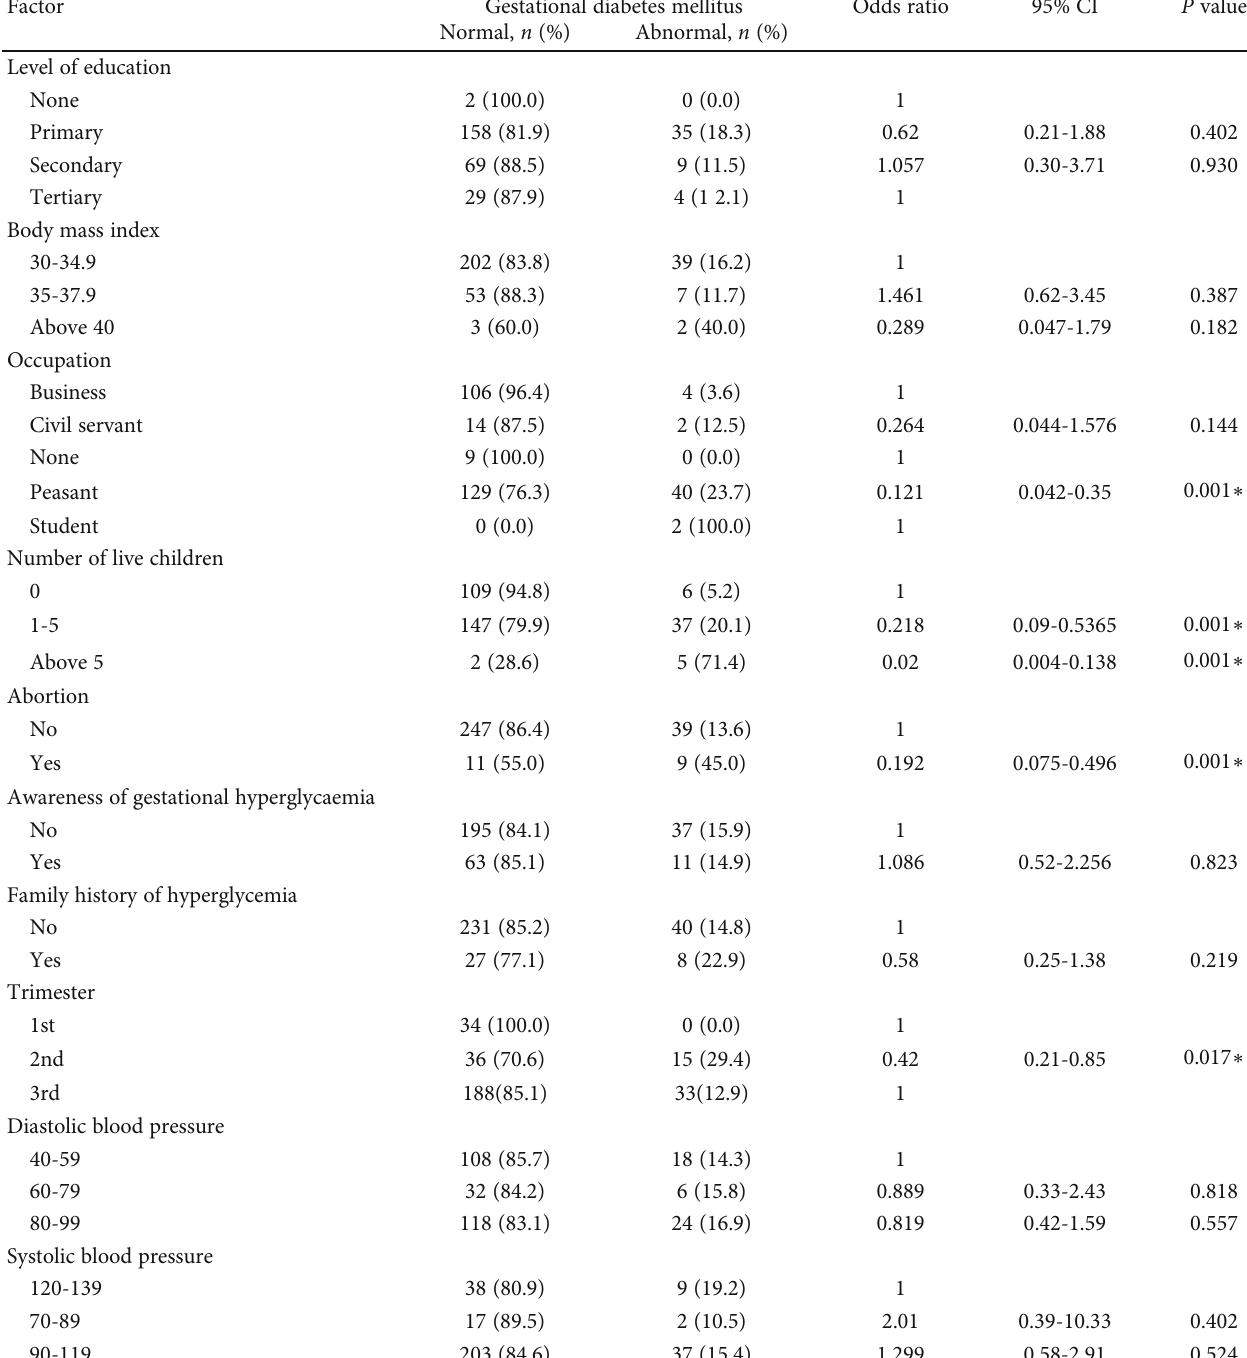
Table 3: Maternal risk factors associated with gestational hyperglycaemia, N = 307